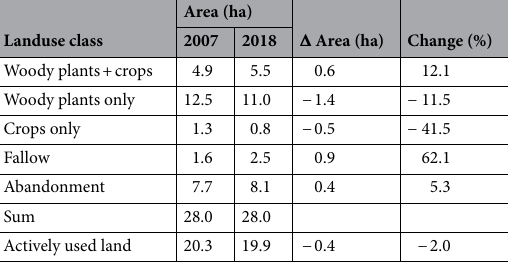
Table 2. Landuse of terraces in the oases of Wadi Muyadin, Al Jabal Al Akhdar, northern Oman, in 2007 and 2018. Data of 2007 are from Luedeling and Buerkert 11 .